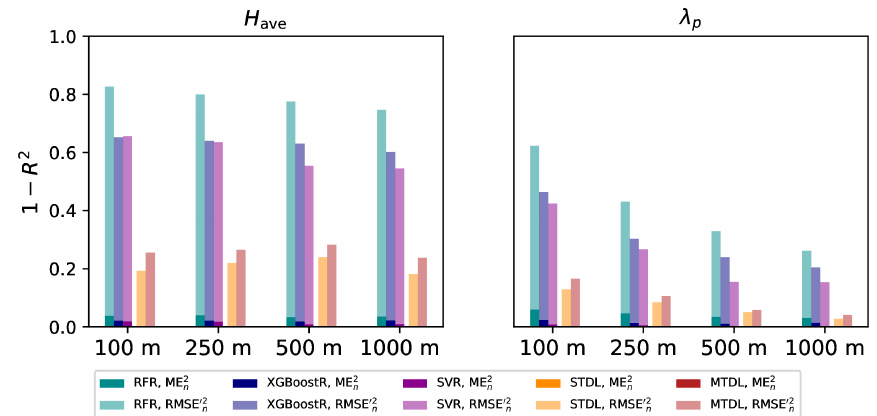
Figure 10. Decomposition of 1 − R 2 for model predictions.